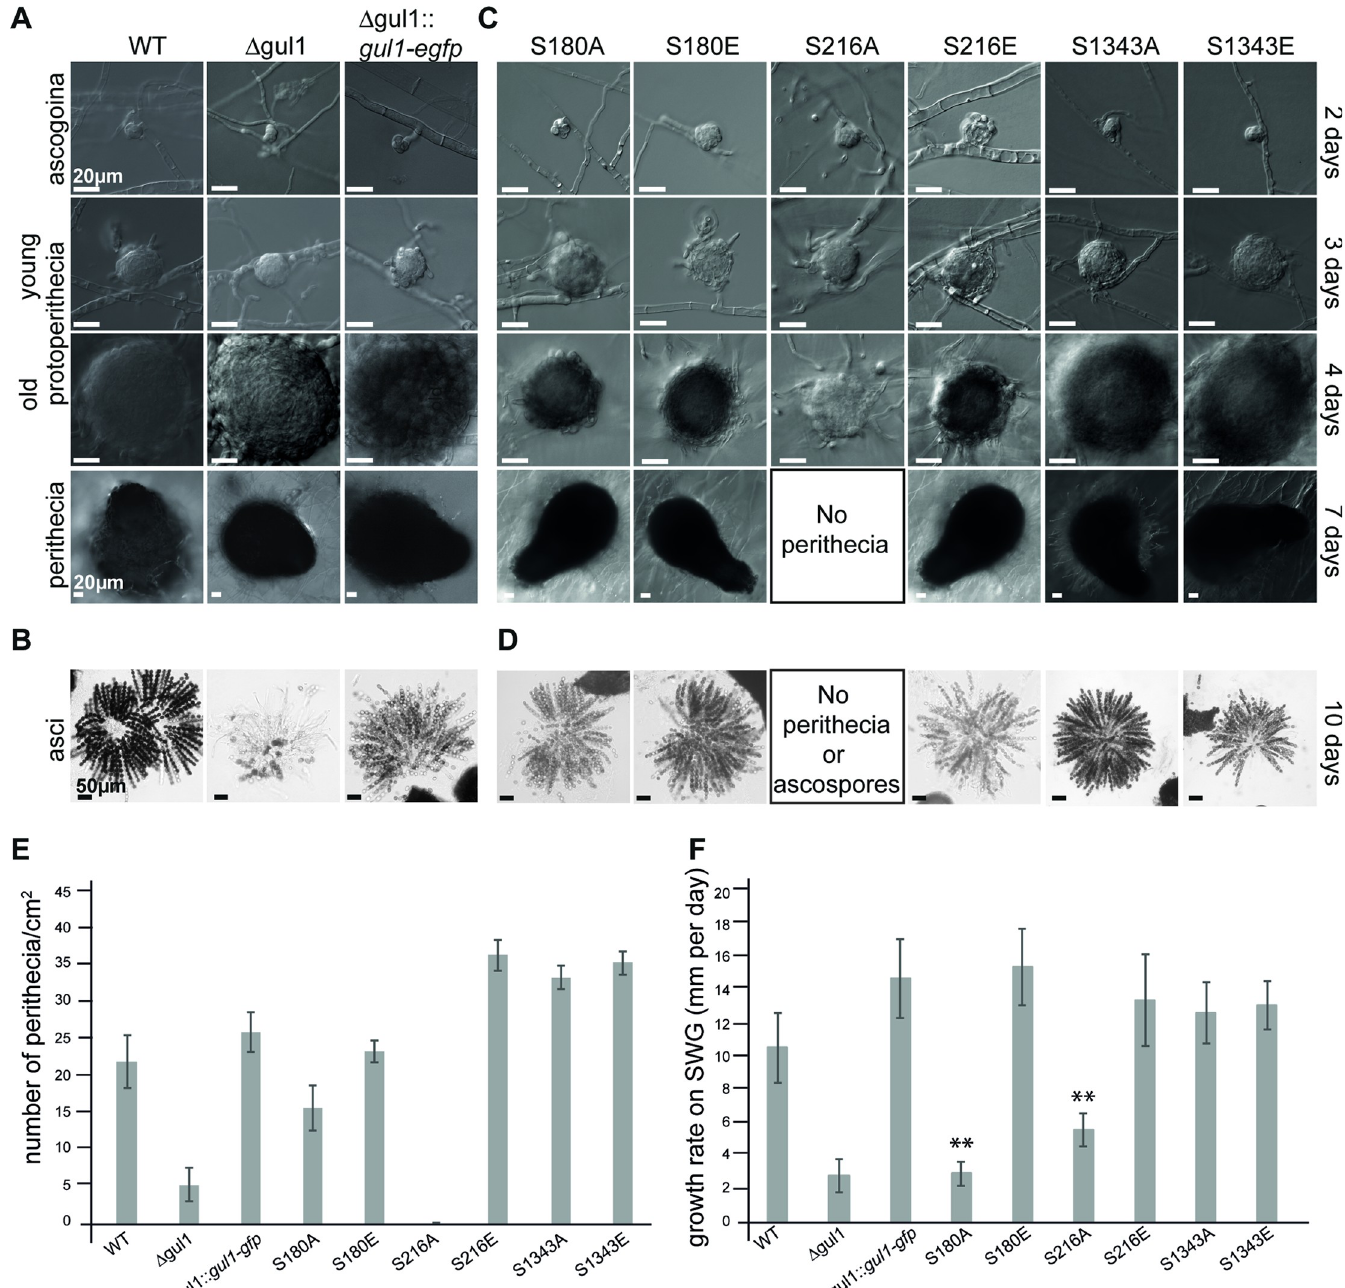
Fig 3. Phenotypic analysis of wild type, Δ gul1, a complemented Δ gul1 strain ( Δ gul1:: gul1-gfp ),and phospho-mimetic and–deficient GUL1 strains. (A, B) Sexual development. Ascogonia, young and old protoperithecia, as well as perithecia were examined after 2, 3, 4, and 7 days of growth BMM-slides. Samples were grown on BMM-medium. All bars represent 20 μ m. (C, D) Wild type and the Δ gul1:: gul1-gfp complete ascus rosettes, while the gul 1 deletion strain forms only a few ascospores. Phospho-deficient GUL1 strain S180A and both phospho-mimetic GUL1 strains S180E and S216E show complete ascus rosettes. Phospho-deficient GUL1 strain S216A does not form any spores. Phospho-deficient GUL1 strain S1343A and phospho-mimetic GUL1 strains S1343E show a wild-type like fertility. Bar represent 50 μ m. (E) Quantification of perithecia per square centimetre on solid BMM-medium after 10 days ( n = 9). (F) Growth rate of GUL1 phospho-mutants compared to Δ gul1:: gul1-gfp on SWG. Asterisks indicate significant differences compared to the complemented strain. Error bars in E and F indicate the standard deviation.